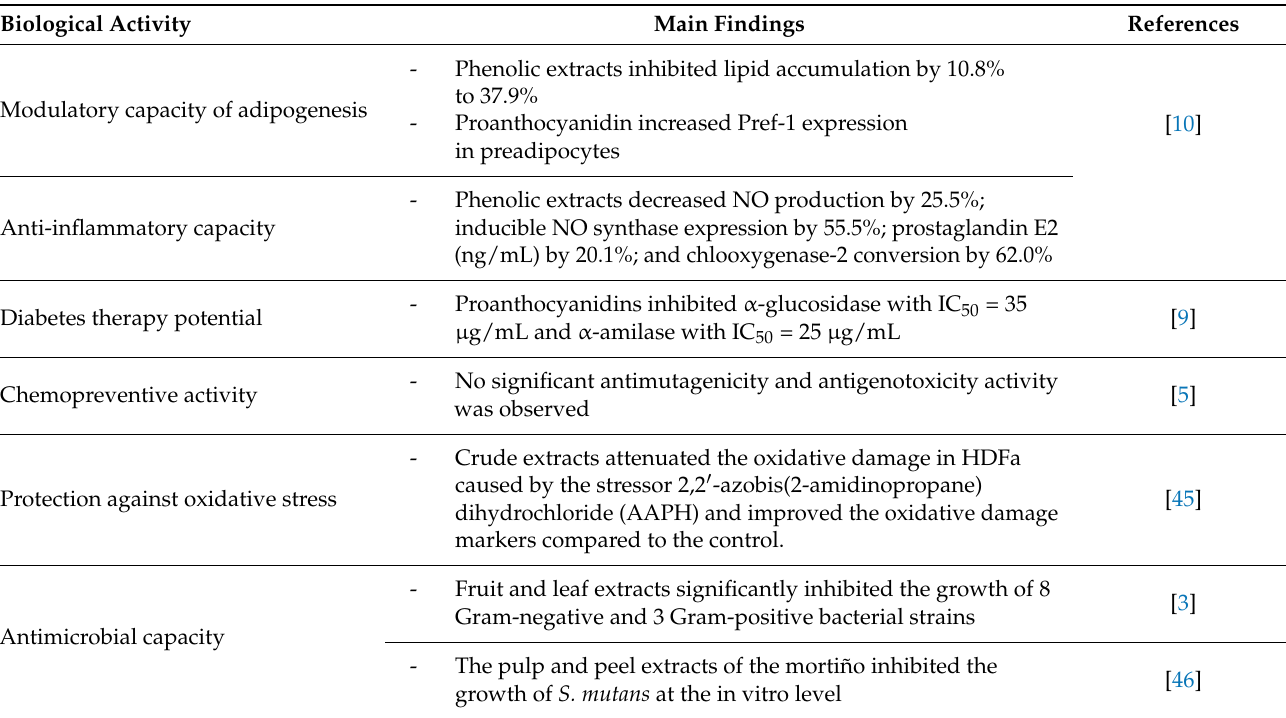
Table 3. Medicinal properties of Vaccinium floribundum